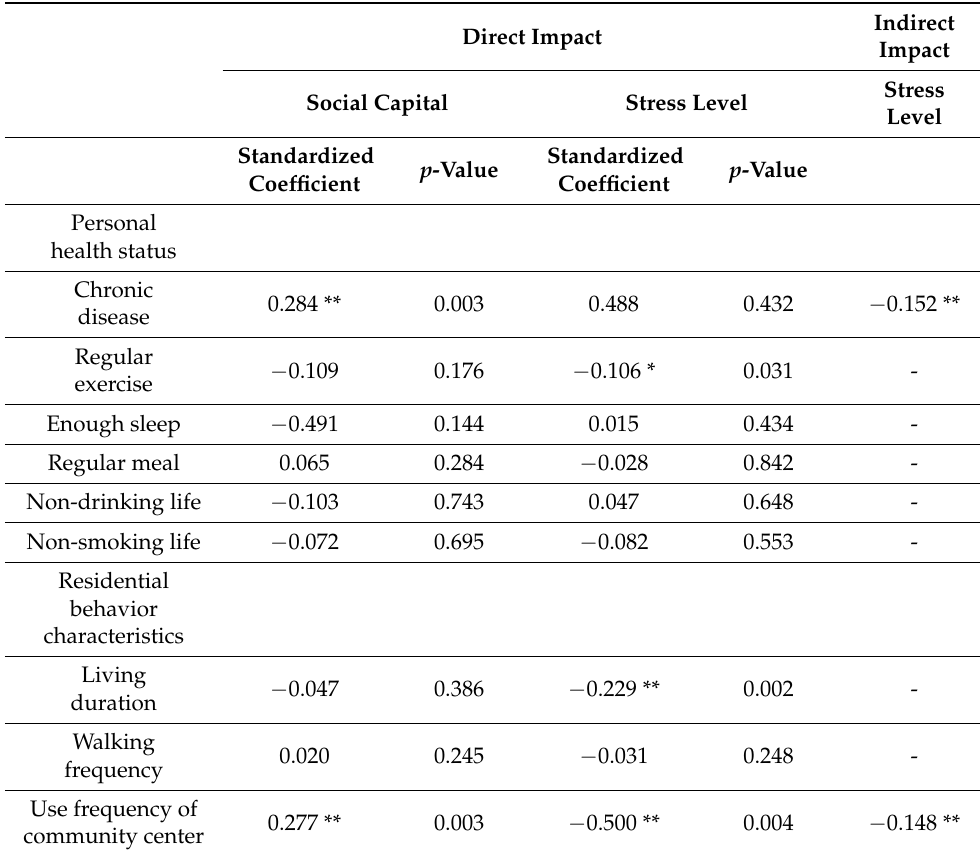
Table 3. The direct and indirect relationships between personal health status, residential behavior characteristics, social capital, and stress level.